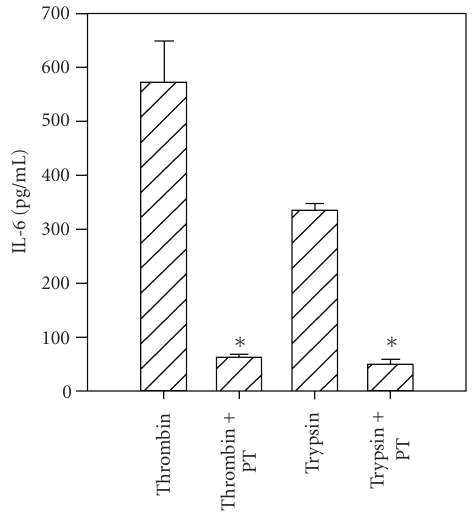
Figure 5: Inhibition of thrombin- and trypsin-induced IL-6 produc- tion by pertussis toxin . The HCEC monolayers were incubated with pertussis toxin (PT) (1 μ g/mL) for 30 minutes and challenged with thrombin (220nM) or trypsin (220nM). Unactivated cells pro- duced 107 ± 12pg/mL of IL-6. The results presented are representa- tive of two independent experiments. ∗ indicates P < .05 when compared to medium